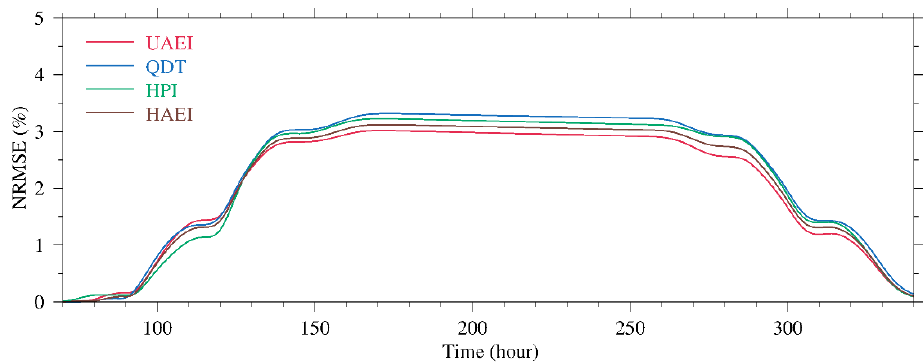
Figure 7. Normalized root mean square error (%) in the refined subdomain.